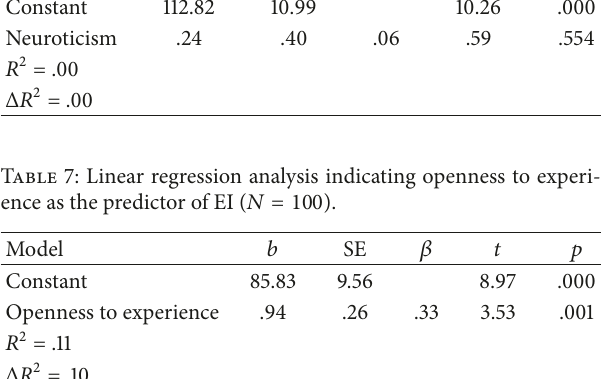
Table 4: Linear regression analysis indicating agreeableness as the predictor of EI ( 𝑁 = 100 ).